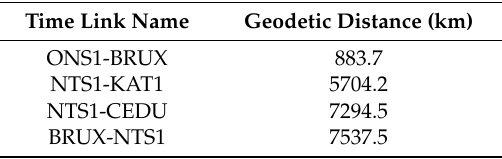
Table 2. Time links formed and their geodetic distances.